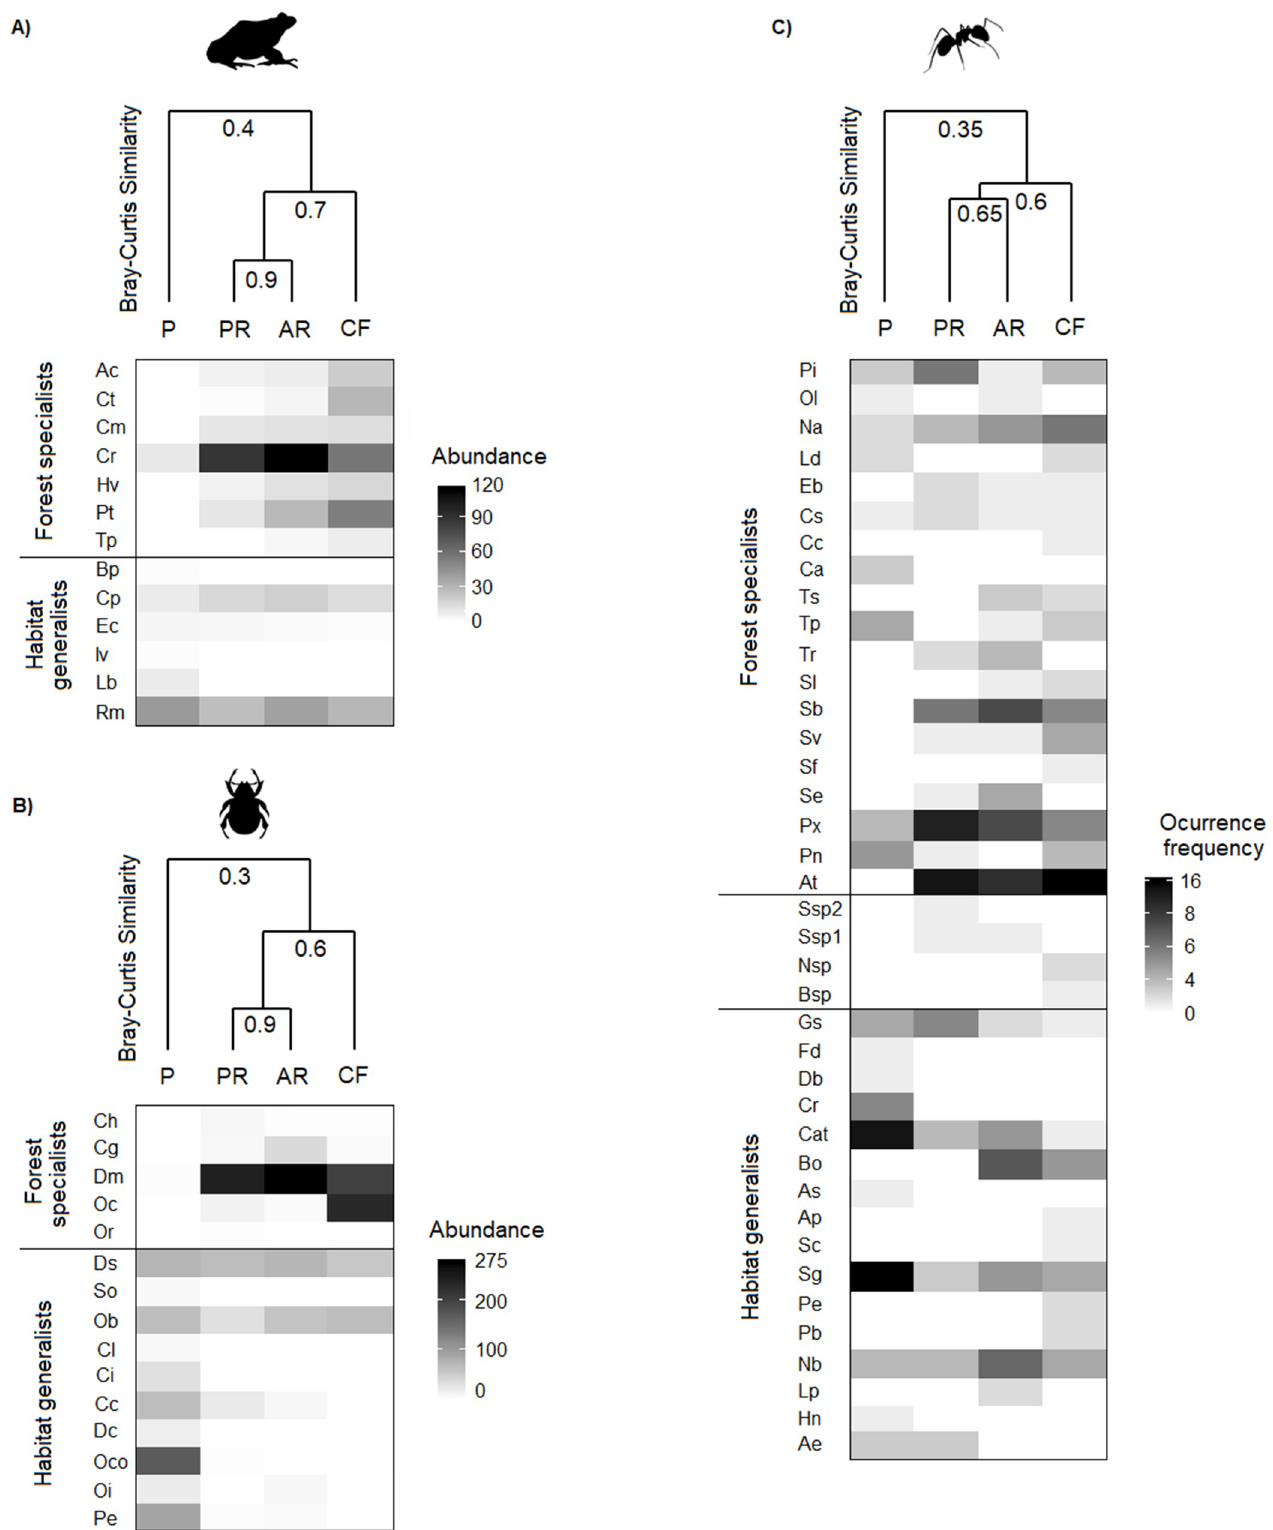
Fig 4. Dendrogram of similarity (Bray-Curtis index) and heatmap based on amphibian abundance (a), dung beetle abundance (b), and ant occurrence- frequency (c) in four vegetation types: P = cattle pasture, PR = forest under passive restoration, AR = forest under active restoration and CF = mature